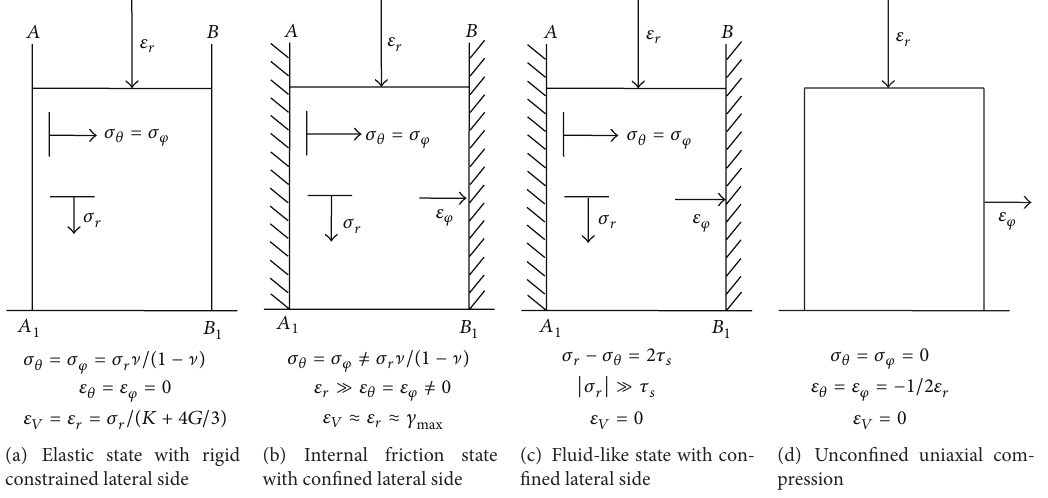
Figure 3: The material deformation under